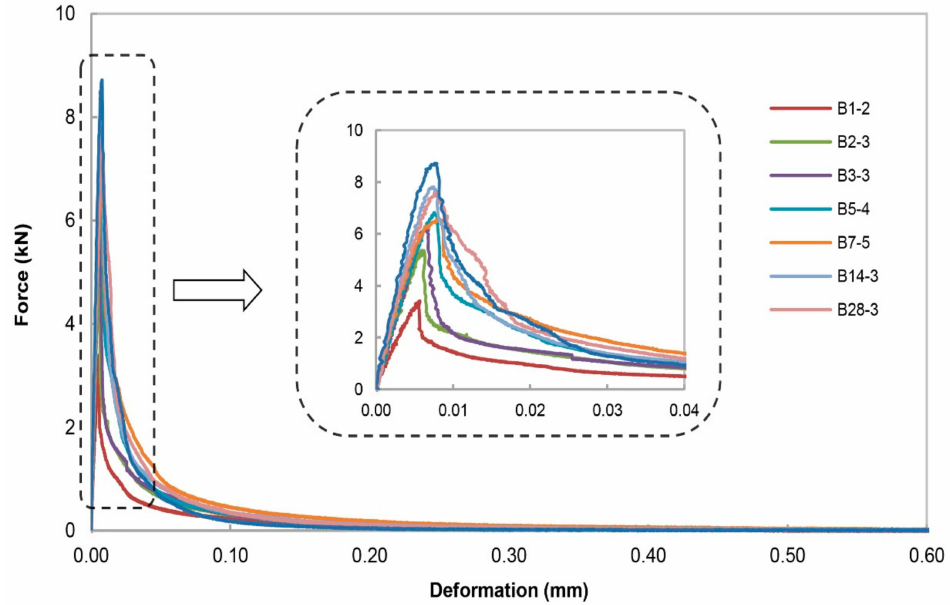
Figure 7. Overview of the force-deformation curves for specimen type 6.3 that were fractured at the center of the specimen as a function of testing age. ‘B1’ represents the specimen type 6.3 tested at an age of 1 day after casting; ‘-2’ represents the order number of the specimen for each specific